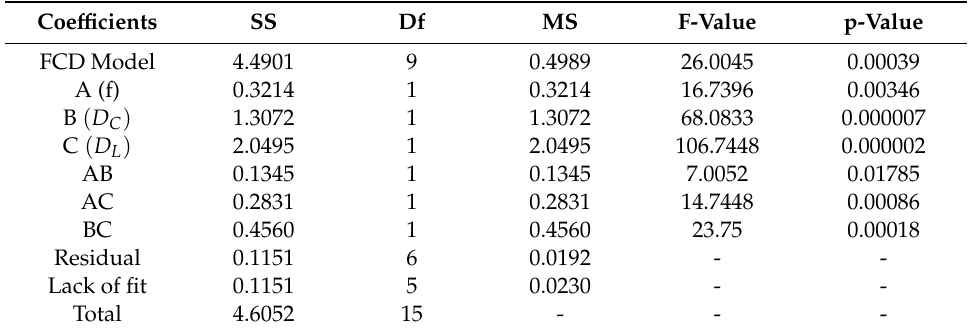
Table 6. Analysis of variance (ANOVA) chart for thermoacoustic e ffi ciency at “Junction”. Faced centered design,